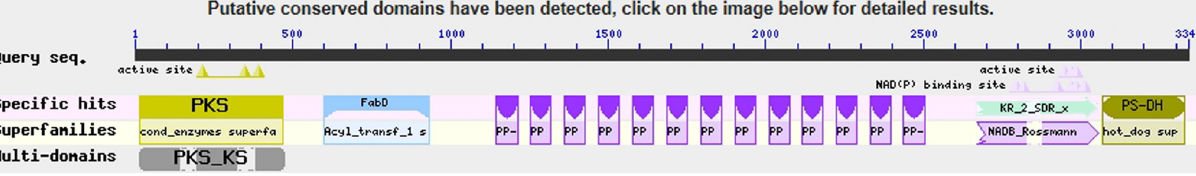
Fig 2. Conservative domains of amino acids of PKS3, including 3-ketoacyl synthetase enzyme domain (KS), acyltransferase enzyme domain (FabD), 3-ketoacyl-ACP reductase enzyme domain (KR), dehydratase enzyme domain (DH) and thirteen phosphopantetheine-binding sites (pp- binding